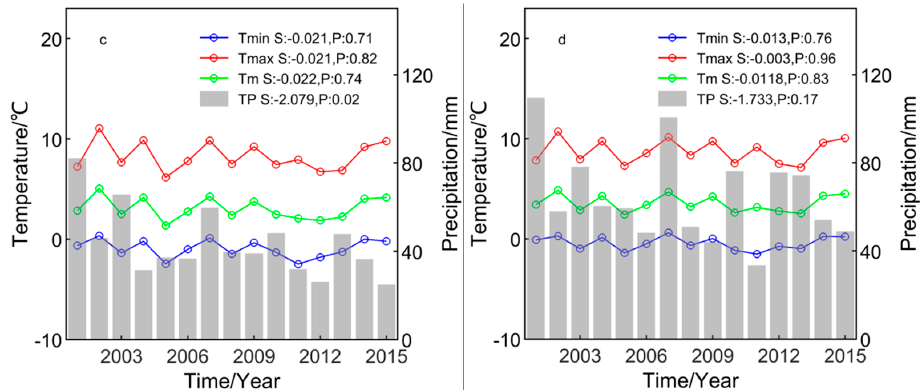
Figure 9. Variations of the different preseason T m , TP , T max , T min for the winter wheat area in NCP over the study period. ( a – d ) indicate T0, T1, T2, and T3, respectively. The texts in the upper right corner of each figure present the slope (S) and significance (P) of the linear regression.